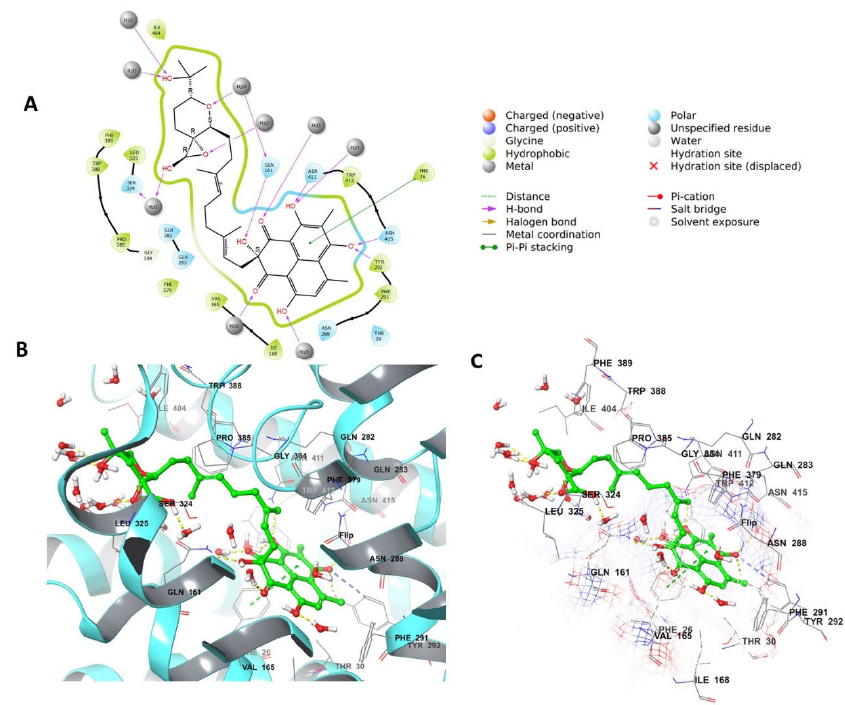
Figure 16. GLUT1 ‐ 60 complex after docking. ( A ) 2D view of the binding interactions between 60 complexed with GLUT1 (PDB: 5EQG). ( B ) 3D view of the binding interactions between 60 complexed with GLUT1 (PDB: 5EQG). ( C ) The 3D view of GLUT1 ‐ 60 complex with the mesh surface view. As for compound 64 , the carbonyl oxygens and the OH groups of the 3 ‐ membered ring system formed several water bridges and H ‐ bonds with the water molecules and His160 and Gln161 side chains. The aliphatic chain and the cyclopentyl moiety interacted with Asn415 and the adjacent water molecules through the OH groups (Figure 17).